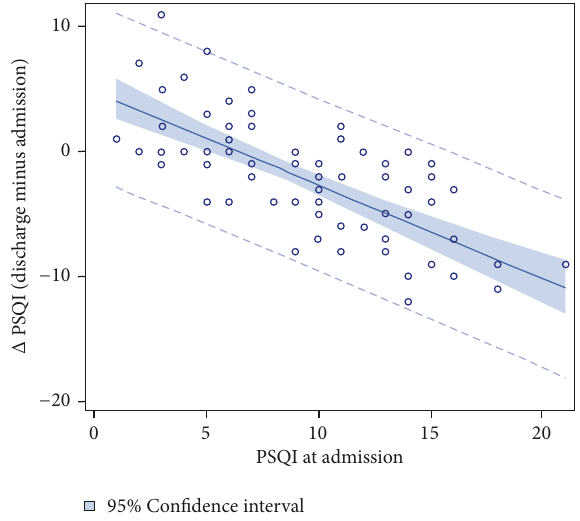
Figure 3: Regression analysis of the change in PSQI in relation to PSQI at admission . Regression: (cid:2) PSQI= 4.9- 0.752 ∗ PSQI at admission (p < 0.0001; R2 =